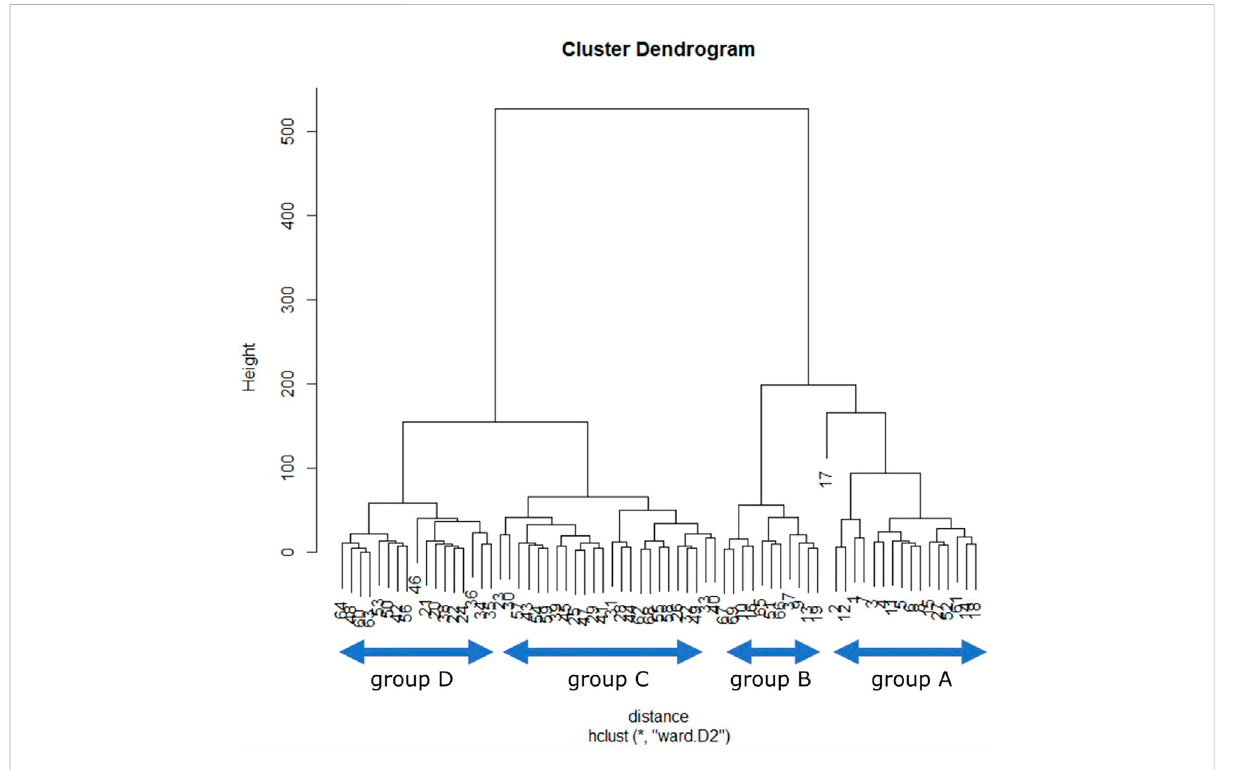
FIGURE 11 Hierarchical clustering results for 76 contents for book